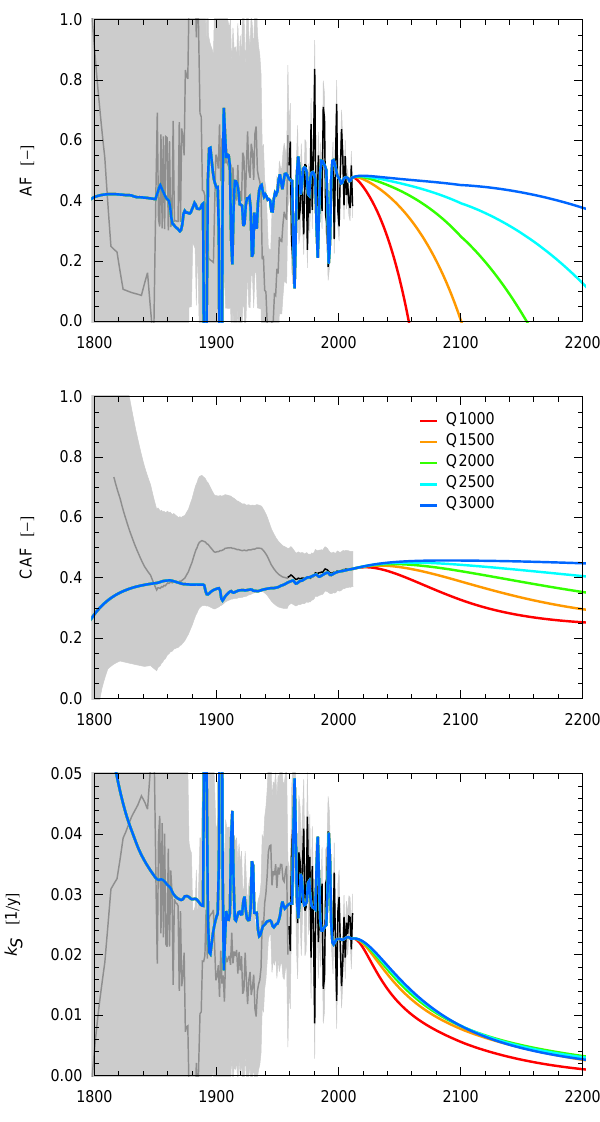
Fig. 7. SCCM predictions of AF, CAF and k S with analytic sce- narios for future emissions of CO 2 and non-CO 2 gases (CH 4 , N 2 O, CFCs) yielding cumulative total CO 2 emissions Q E ( ∞ ) from 1000 to 3000PgC. Model details as for Fig. 6. Error bands on ob- servations are ± 1 σ . Data sources: Appendix